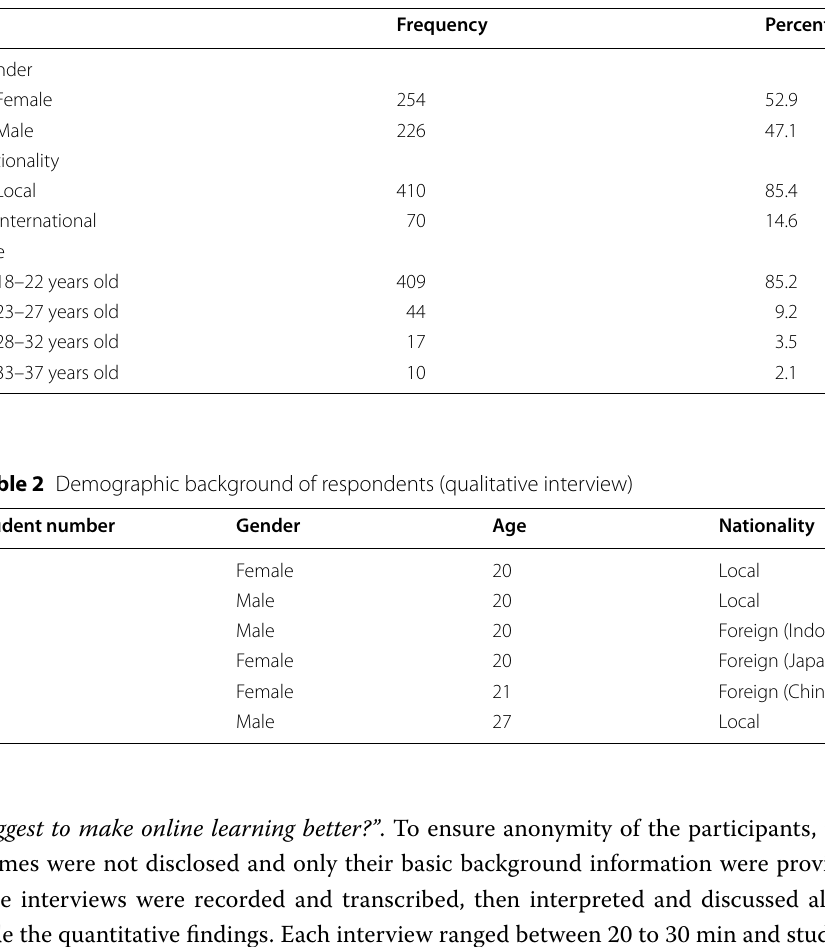
Table 1 Demographic background of respondents (quantitative survey)